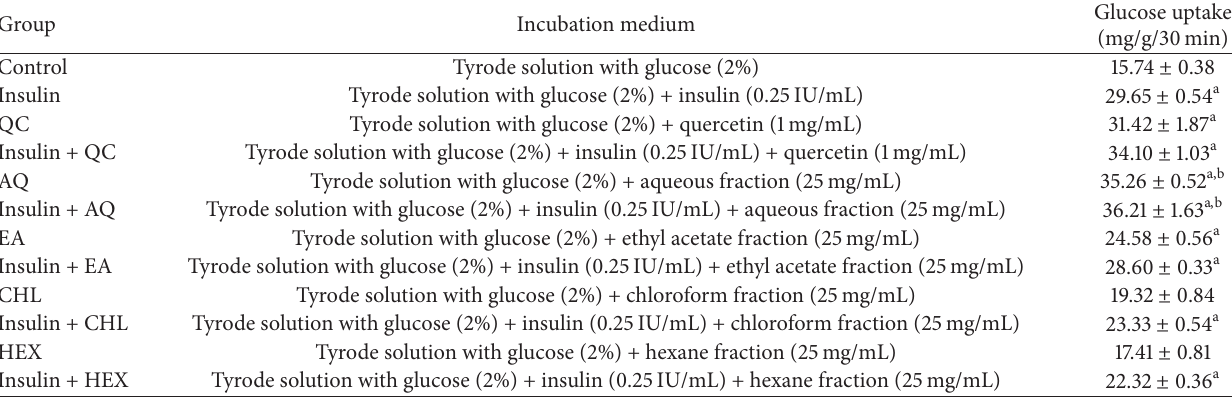
Table 1: Effect of different fractions of H. cordata on glucose utilization by isolated rat hemidiaphragm.